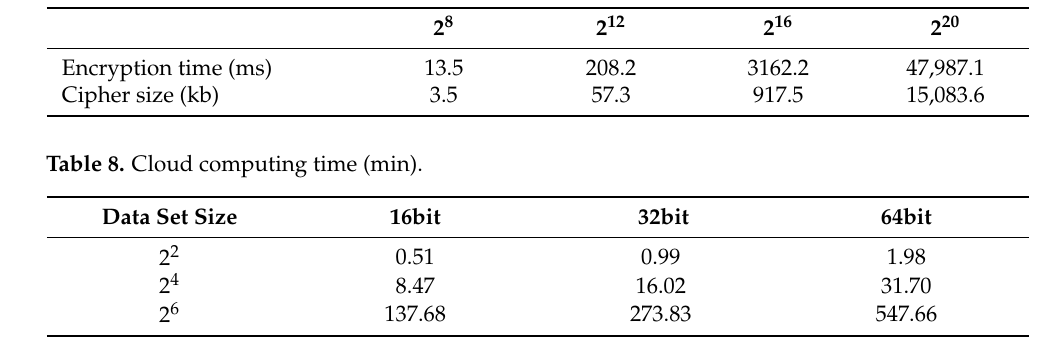
Table 7. Cost during encryption.